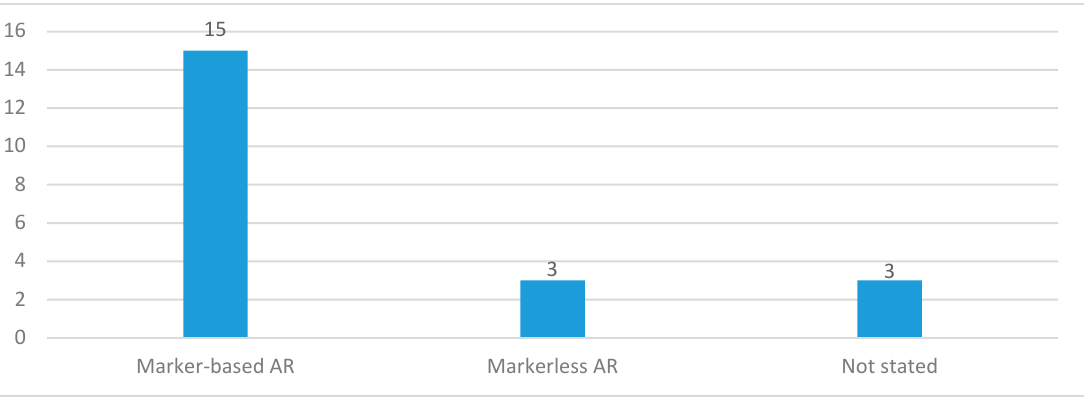
Figure 6. The number of studies in each applied AR system.